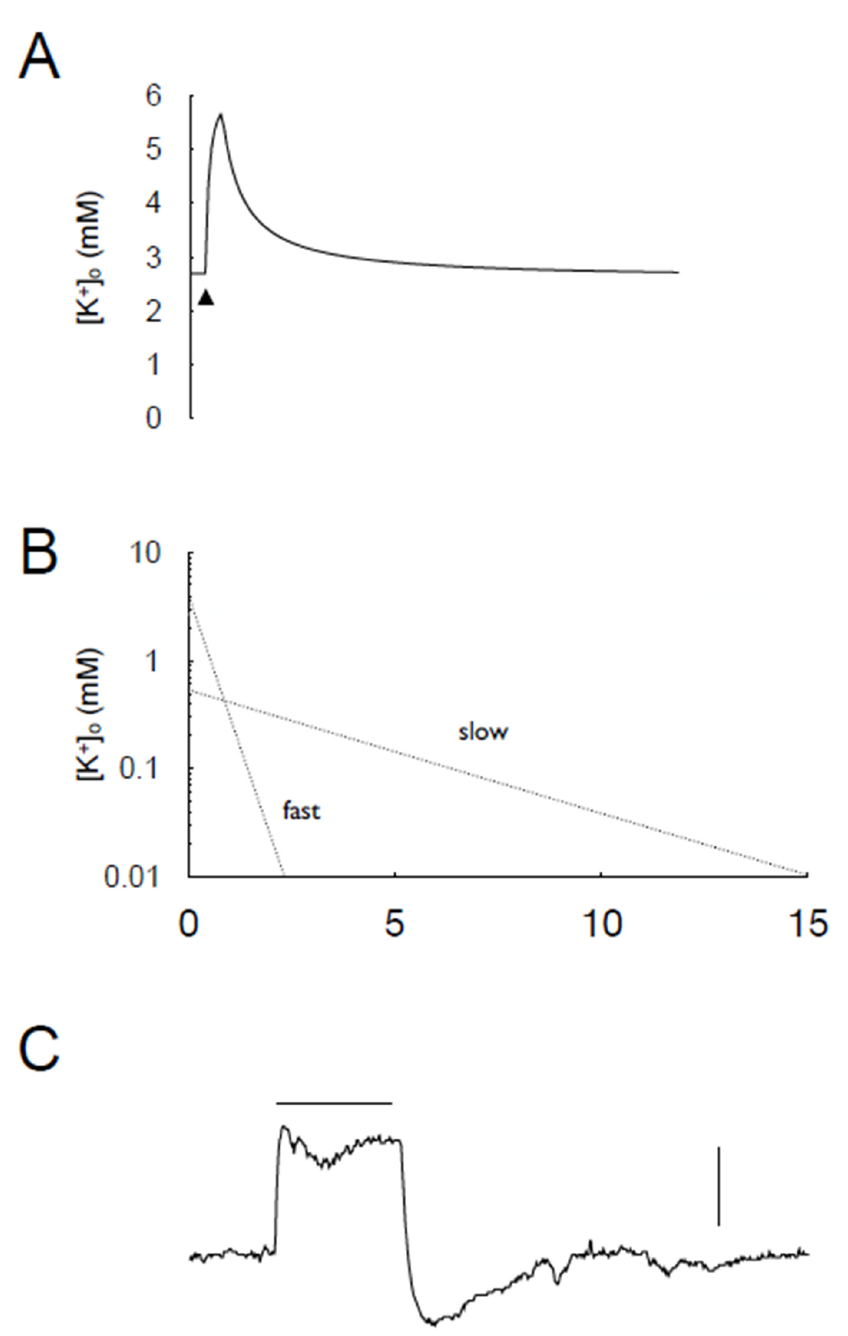
Figure 7. Buffering of interstitial K + in rodent optic nerve. ( A ) A stimulus of 100 Hz for 10 s leads to a rapid increase in [K + ] o , which declines rapidly on cessation of firing. ( B ) The buffering of K + can be ascribed to two processes, characterised by a fast or slow time constants (adapted from Ref. [34]). ( C ) Imposing 100 Hz stimulus for 2 min (horizontal bar) in mouse optic nerve leads to a transient increase in [K + ] o (scale bar = 1 mM) that plateaus despite continuing stimulus, followed by a rapid fall in [K + ] o below baseline before recovering to baseline concentration.